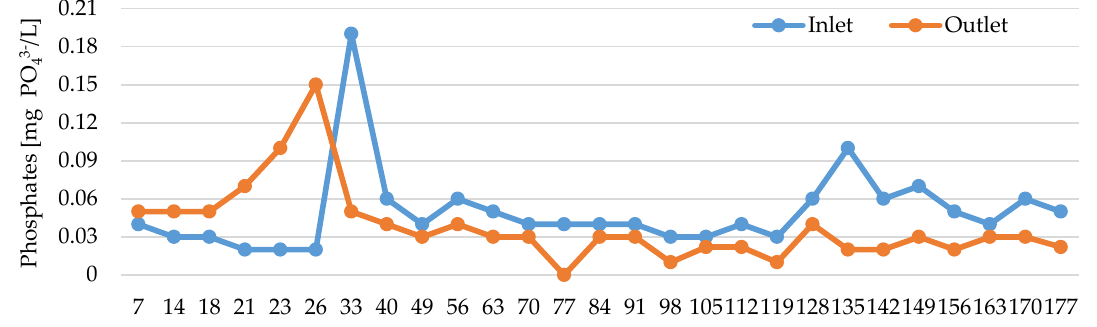
Figure 12. Change of phosphate content in the inflow and outflow water from the experimental installation.